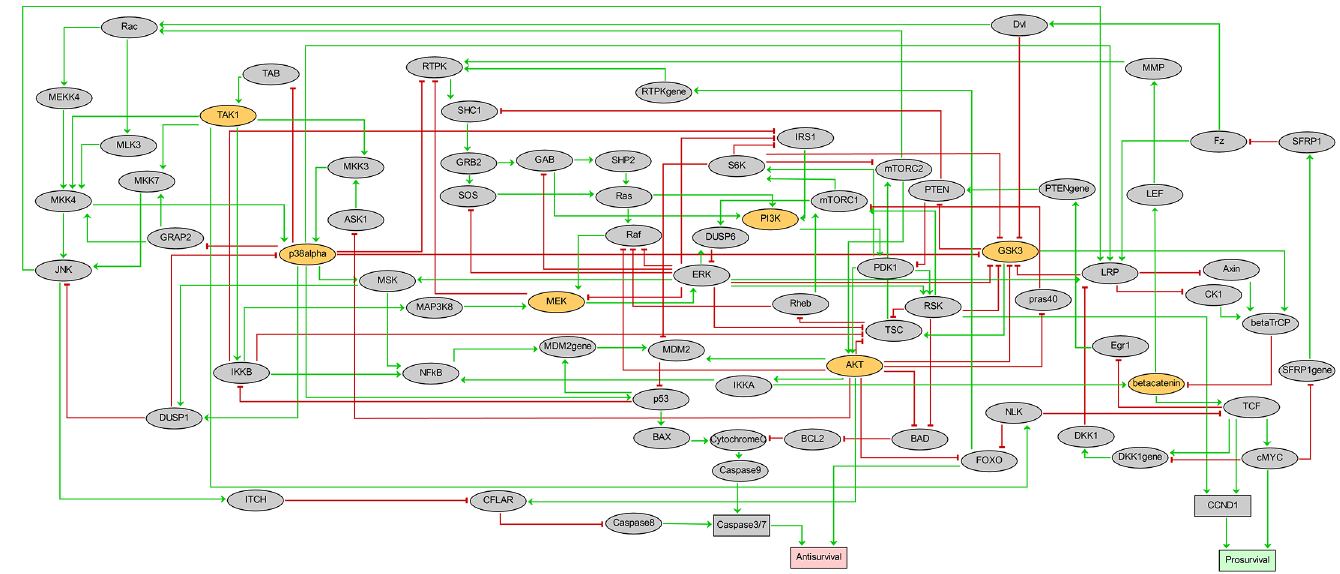
Fig 2. Prior knowledge network representing the cell fate decision network governing growth of AGS gastric adenocarcinoma cells. The network receives no external input but encompasses two outputs Antisurvival and Prosurvival (phenotypic readouts, colored in red for Antisurvival and green for Prosurvival). Activating regulations are denoted by green arrows, while red T arrows denote inhibition. Signaling component nodes (proteins, protein complexes or genes) associated with Boolean variables (taking the values 0, 1) are represented by ellipses, while rectangles depict nodes encoded with multilevel variables. Yellow nodes represent drug targets and are subjected to inhibitory perturbations during simulations.